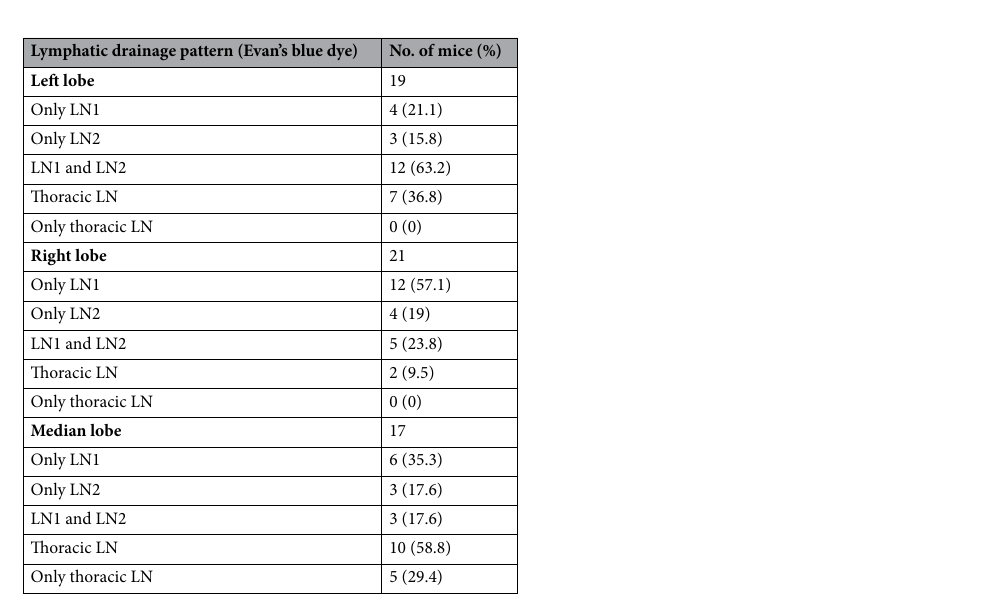
Table 1. Overview of lymphatic drainage patterns per